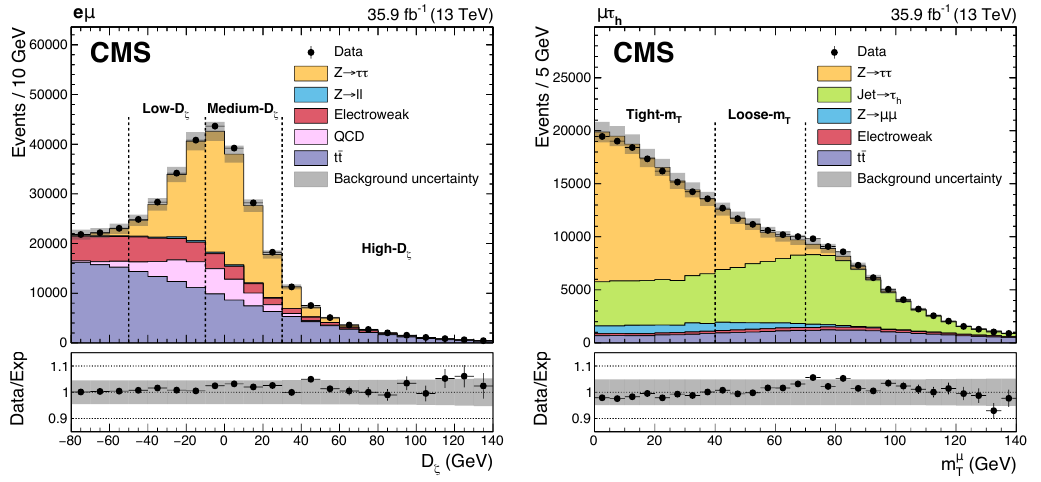
Figure 2 . Observed and expected distributions of (left) D (cid:16) in the e (cid:22) (cid:12)nal state and (right) m (cid:22) the (cid:22)(cid:28) h (cid:12)nal state. The dashed vertical lines indicate the de(cid:12)nition of the subcategories in each (cid:12)nal state. The label \jet ! (cid:28) h " indicates events with jets misidenti(cid:12)ed as hadronic (cid:28) lepton decays, e.g. W+jets events, which are estimated from data as described in section 5.2. A detailed description of the composition of the expected background is given in section 6. The distributions are shown before any event categorization and prior to the (cid:12)t used for the signal extraction. For these (cid:12)gures no uncertainties that a(cid:11)ect the shape of the distributions have been included in the uncertainty